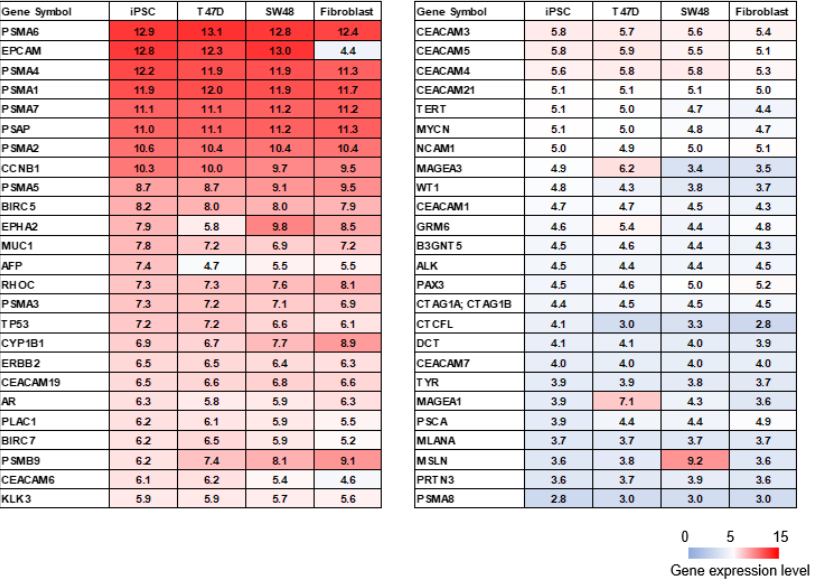
Figure 4. TAAs selected by the NCI Pilot Project. The list shows the ranking of TAAs selected as described previously [39]. The iPSC data were obtained using microarray analysis. The iPSC, SW48 and T47D cell, and fibroblast data were obtained from the NCBI GEO database. The change from red to light purple indicates the gene expression level changing from 15 to 0.